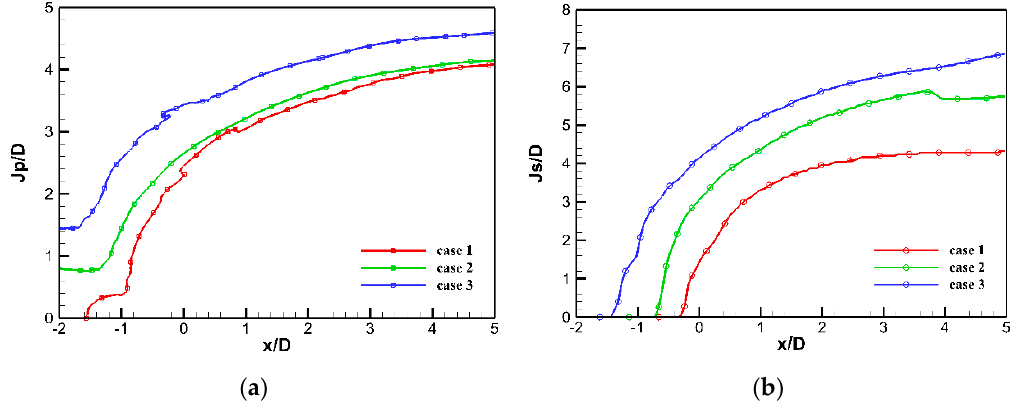
Figure 17. Jet penetration depth (Jp in ( a )) and spread (Js in ( b )). (Y = 0.01 is set as the jet boundary).